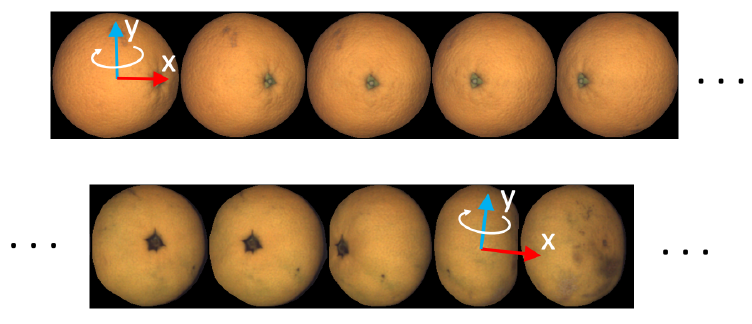
Figure 4. Choice of fruit axes at reference view for spherical ( top ) and oblate ( bottom ) fruit